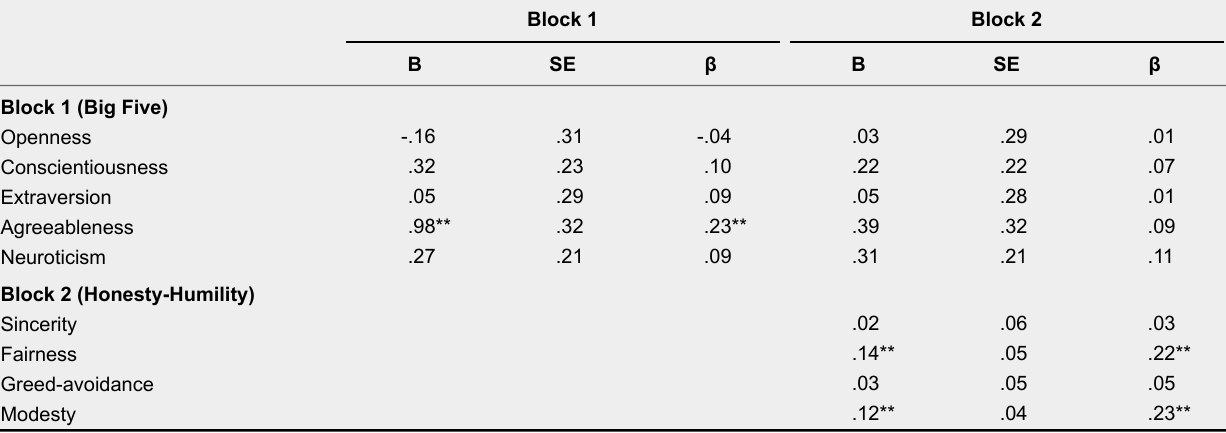
Summary of a Hierarchical Regression Analysis of the Big Five and Honesty-Humility Facets on Liberal